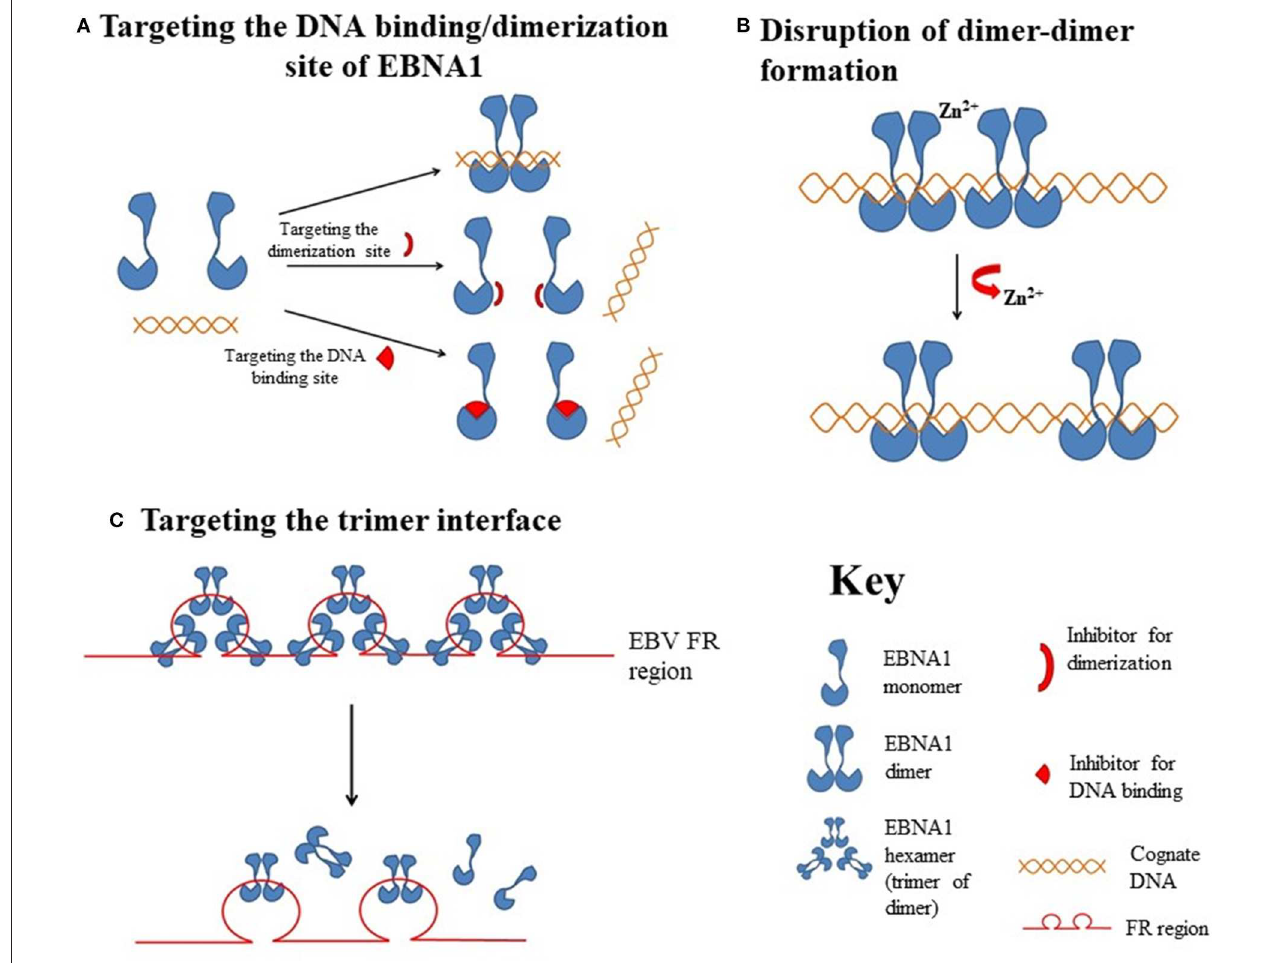
FIGURE 2 | Hypothetical diagrams of the EBNA1-targetable sites for therapeutic intervention. (A) Targeting the DNA binding or dimerization site of EBNA1. (B) Disruption of the EBNA1 dimer-dimer formation. (C) Targeting of the EBNA1 trimer